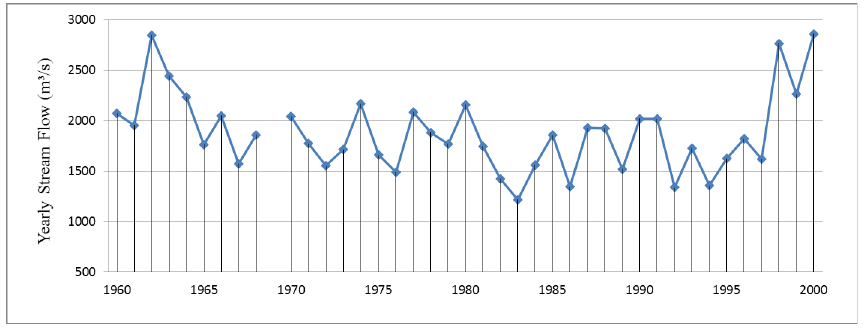
Fig 4. Yearly stream flow observations at Nuxia hydrological station from 1960 to